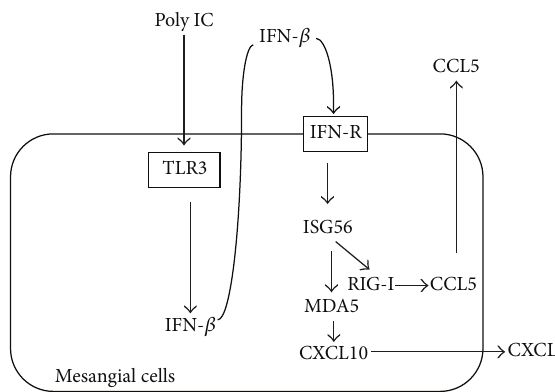
Figure 3: Proposed RIG-I- and MDA5-mediated signaling path- ways via TLR3 activation induced by poly IC in human mesangial cells. (NDT 2010, Tohoku J Exp Med 2012, Am J Nephrol